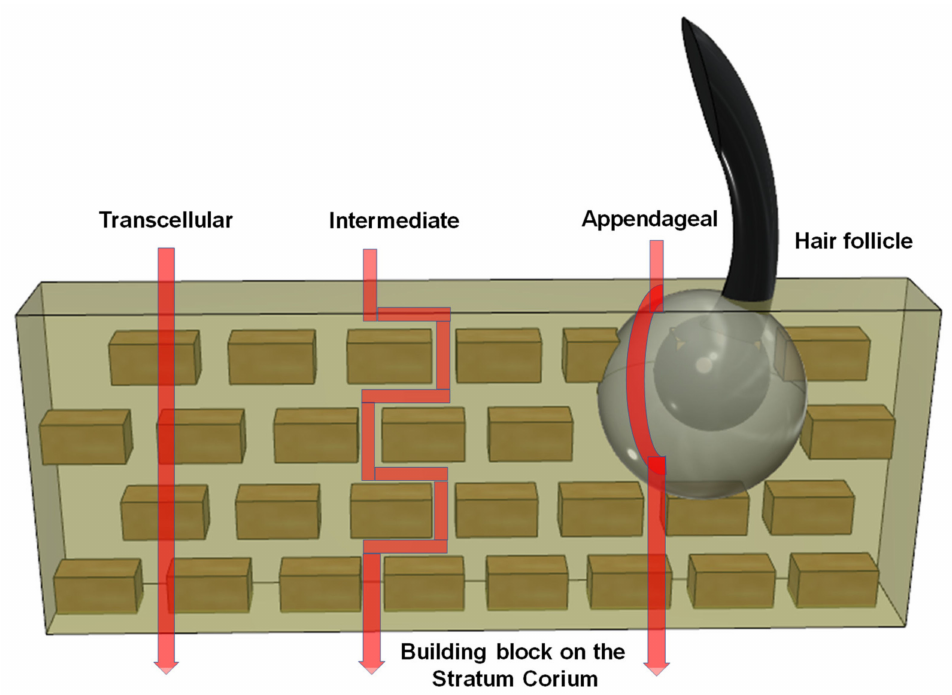
Figure 1. Schematic diagram of the human skin representing the three possible routes for the permeation of fluid substance. The path can be used for ISF